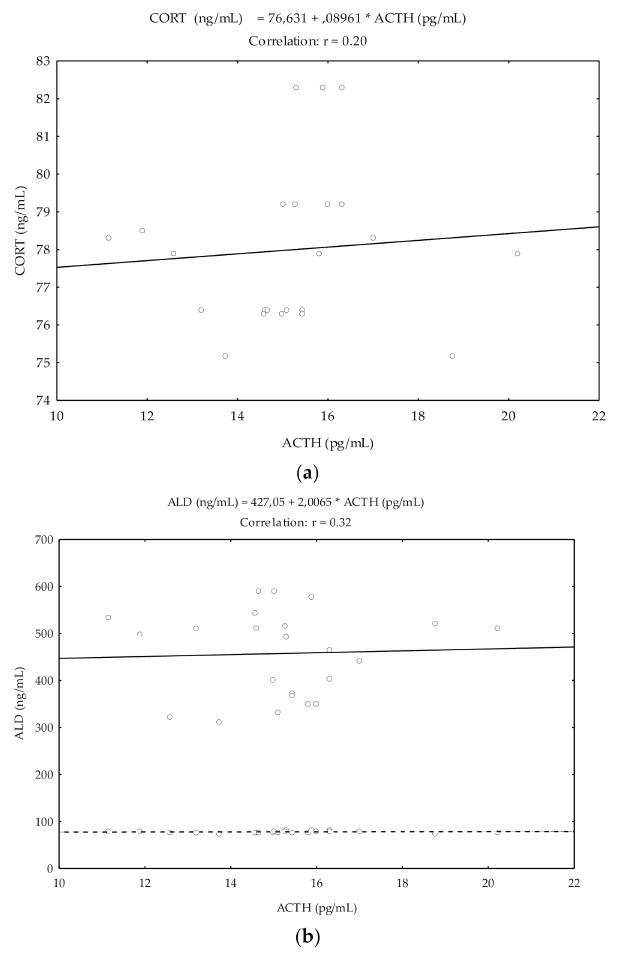
Figure 2. Pearson’s correlation coefficients between ACTH and CORT and between ACTH and ALD in cycling mares (n = 23) from day − 5 pre-ovulation to day 5 post-ovulation. Correlation coefficients between ACTH and CORT ( a ) and between ACTH and ALD ( b